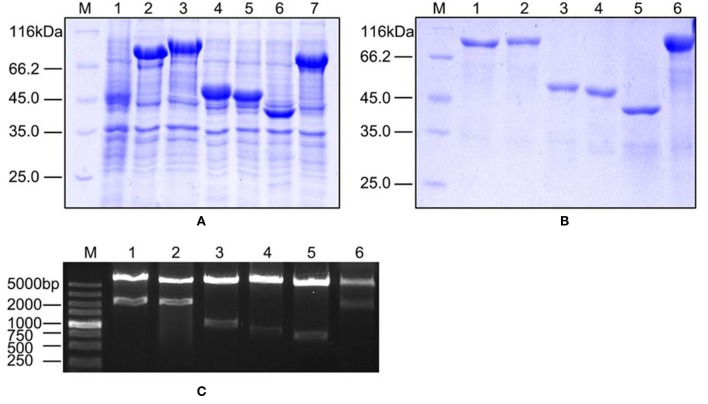
The characteristics of overexpressed and purified recombinant proteins. (A) SDS-PAGE of overexpressed proteins in the BL21 strain. Lane 1: negative control; Lanes 2–7: ORF01609, ORF01830, ORF01839, ORF02943, ORF03355, and ORF03641, respectively. (B) SDS-PAGE of purified proteins. Lanes 1–6: purified ORF01609, ORF01830, ORF01839, ORF02943, ORF03355, and ORF03641, respectively. (C) Restriction enzyme identification of recombinant extracellular protein plasmids carried by the pET-32a vector. M: DL5000 marker; Lanes 1–6: ORF01609, ORF01830, ORF01839, ORF02943, ORF03355, and ORF03641, respectively.